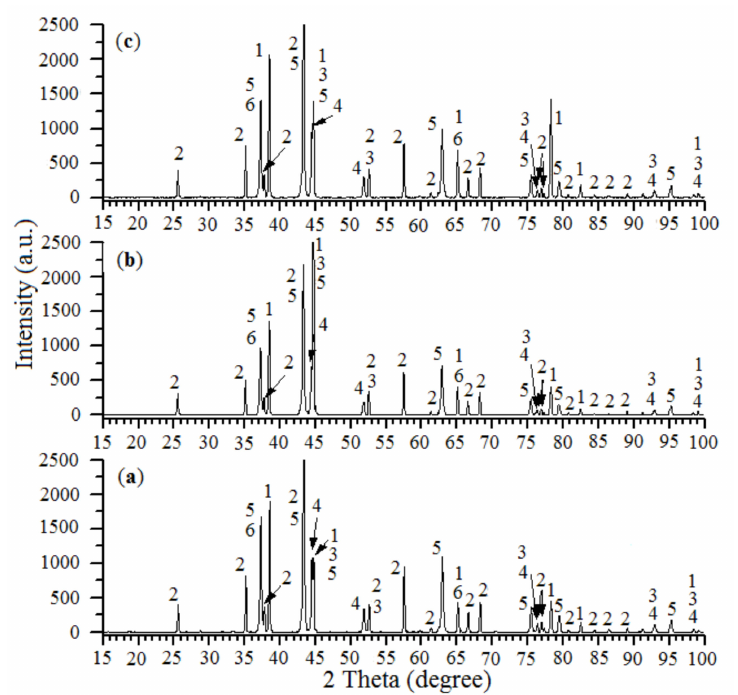
Figure 2. XRD analysis of the NiO–Al–Al 2 O 3 catalysts with different content of elements: ( a ) 24.1% NiO—55.9% Al—20.0% Al 2 O 3 , ( b ) 25.8% NiO, 54.2% Al—20.0% Al 2 O 3 , ( c ) 27.5% NiO—52.5%